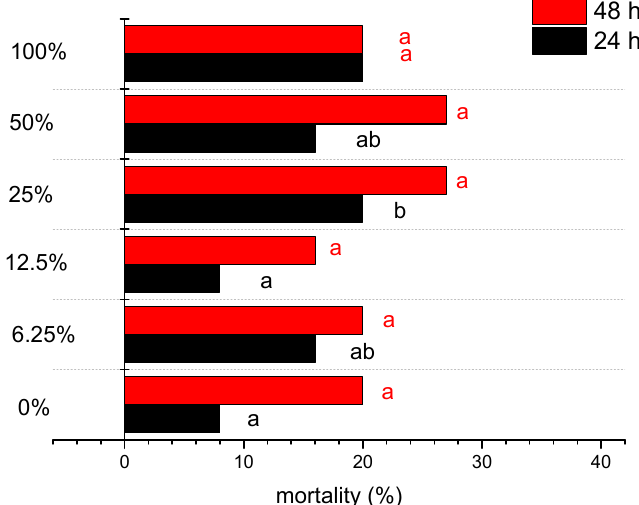
Figure 4. Comparison of the effect of water-extractable substances from PM on the mortality of Daphnia pulex with exposure periods of 24 h and 48 h. Percentages represent the proportion of PM aqueous extract in the culture medium. Different letters indicate statistical significance between additions to a given parameter based on the Tukey post-hoc test ( p < 0.001).